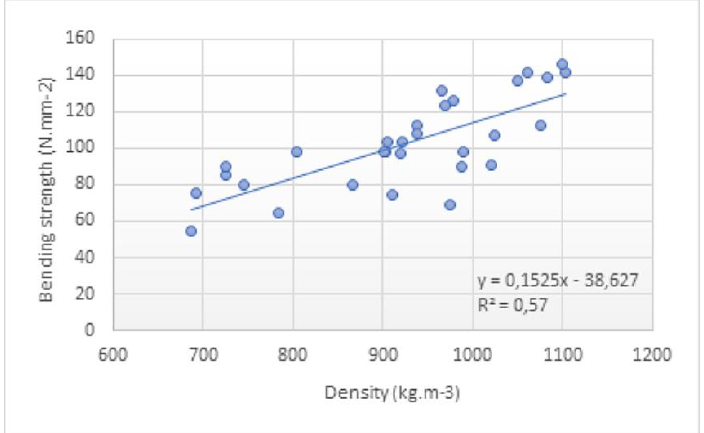
Figure 7. Correlations between bending strength and density for all sites.